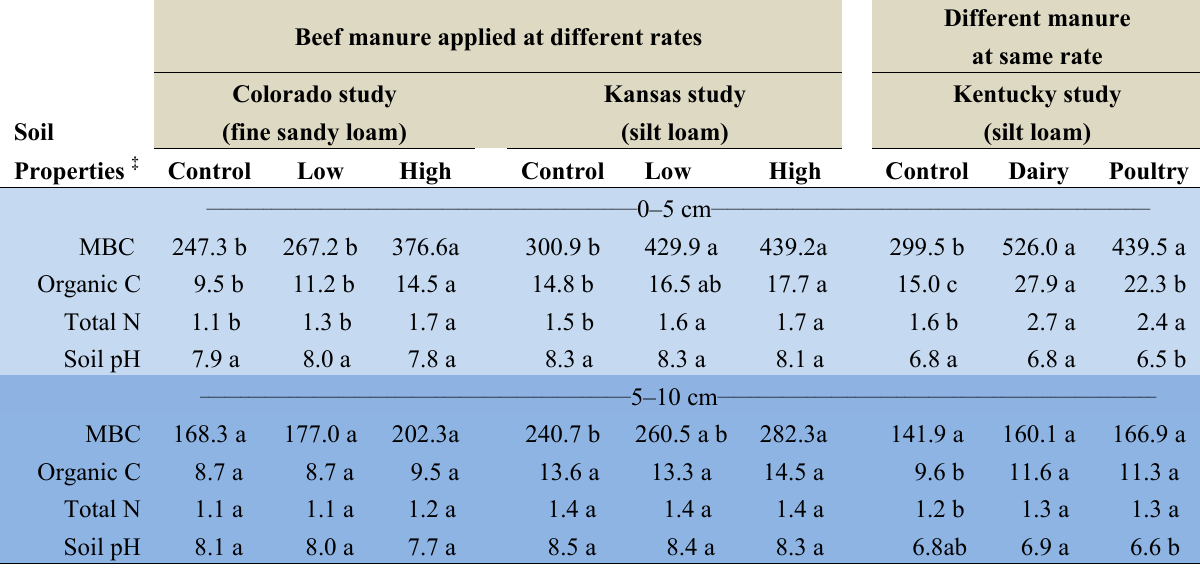
Table 5. Additional soil properties evaluated in the last year of the field studies corresponding to year 2 in CO and year 3 in KS and KY †